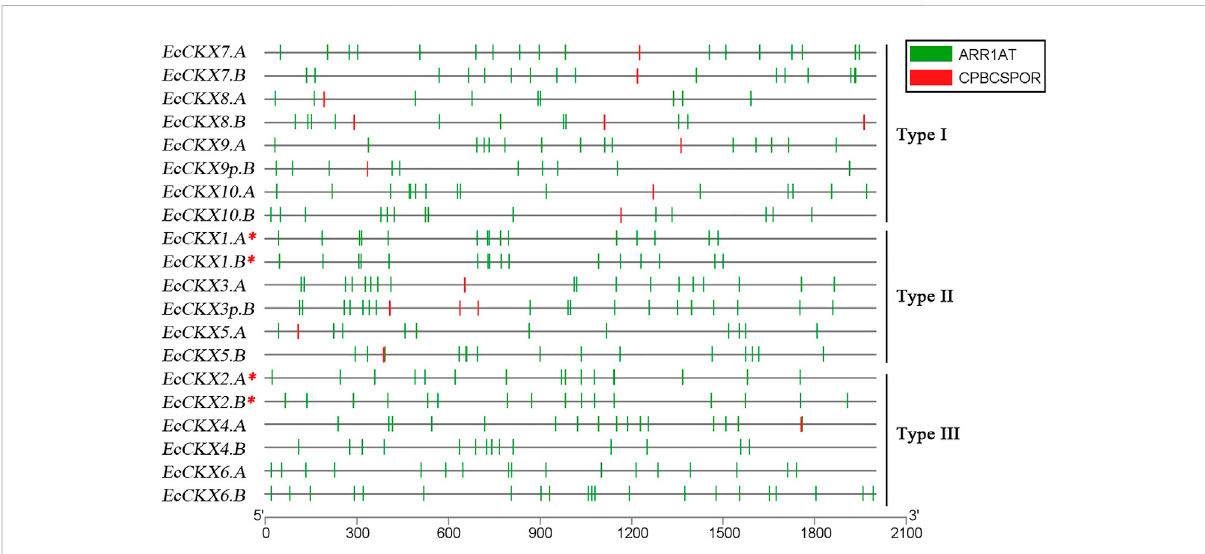
FIGURE 3 Presence of cis -elements, responsible for CK-mediated expression induction, in the 2 kb upstream region of the identi fi ed EcCKX genes of fi nger millet. A red asterix denotes genes identical to previously sequenced and characterized EcCKX1 and EcCKX2